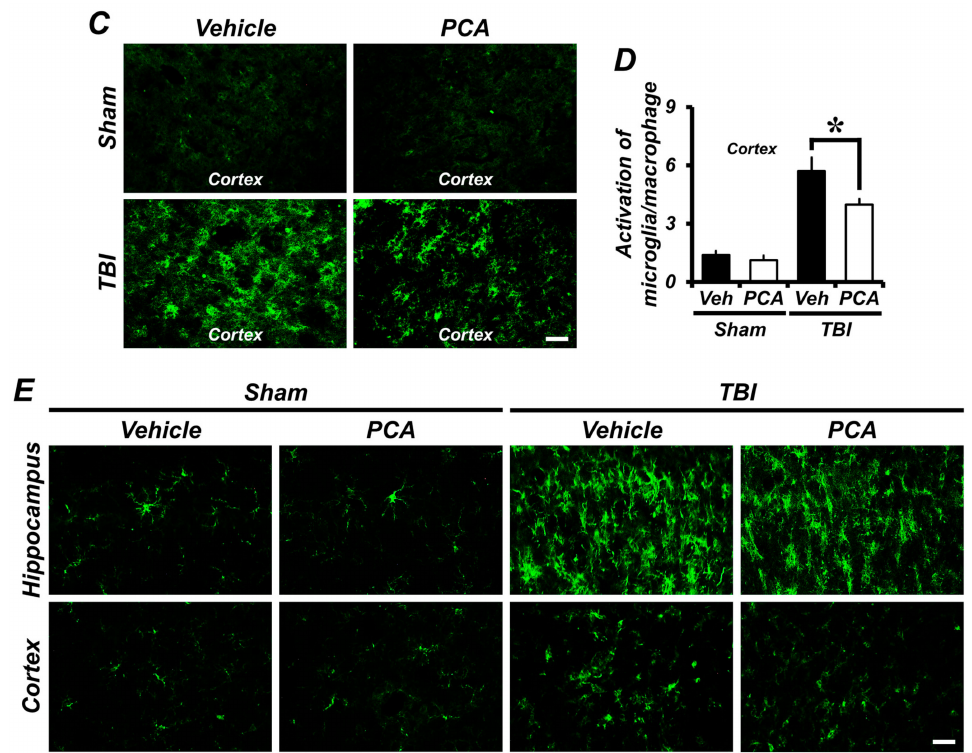
Figure 4. PCA reduces TBI-induced microglia and macrophage activation. ( A , C ) Representative images showed CD11b immunoreactive cells in the hippocampus ( A ) and cortex ( C ). The activation of CD11b-positive microglia and macrophage occurred at one week after TBI. PCA administration reduced the activation of CD11b-positive microglia and macrophage in the hippocampus, compared to the vehicle-treated group. Scale bar = 20 µ m. ( B , D ) The bar graphs represent the grade of CD11b-positive microglia/macrophage activation in the hippocampus ( B ) and cortex ( D ). Data are mean ± SEM, n = 5 from each sham group and n = 10 from each TBI group. * Significantly different from vehicle-treated group, p < 0.05. ( E ) Fluorescence photomicrographs represented Iba1 immunoreactive cells in the hippocampus and cortex. Sham-operated groups showed the resting state of Iba1-positive microglia and macrophage. There was no difference in the Iba1 immunoreactivity (IR) between vehicle- and PCA-treated group. However, TBI caused significant increase of Iba1 IR in the hippocampus and cortex. microglia and macrophage after TBI, compared to the vehicle-treated